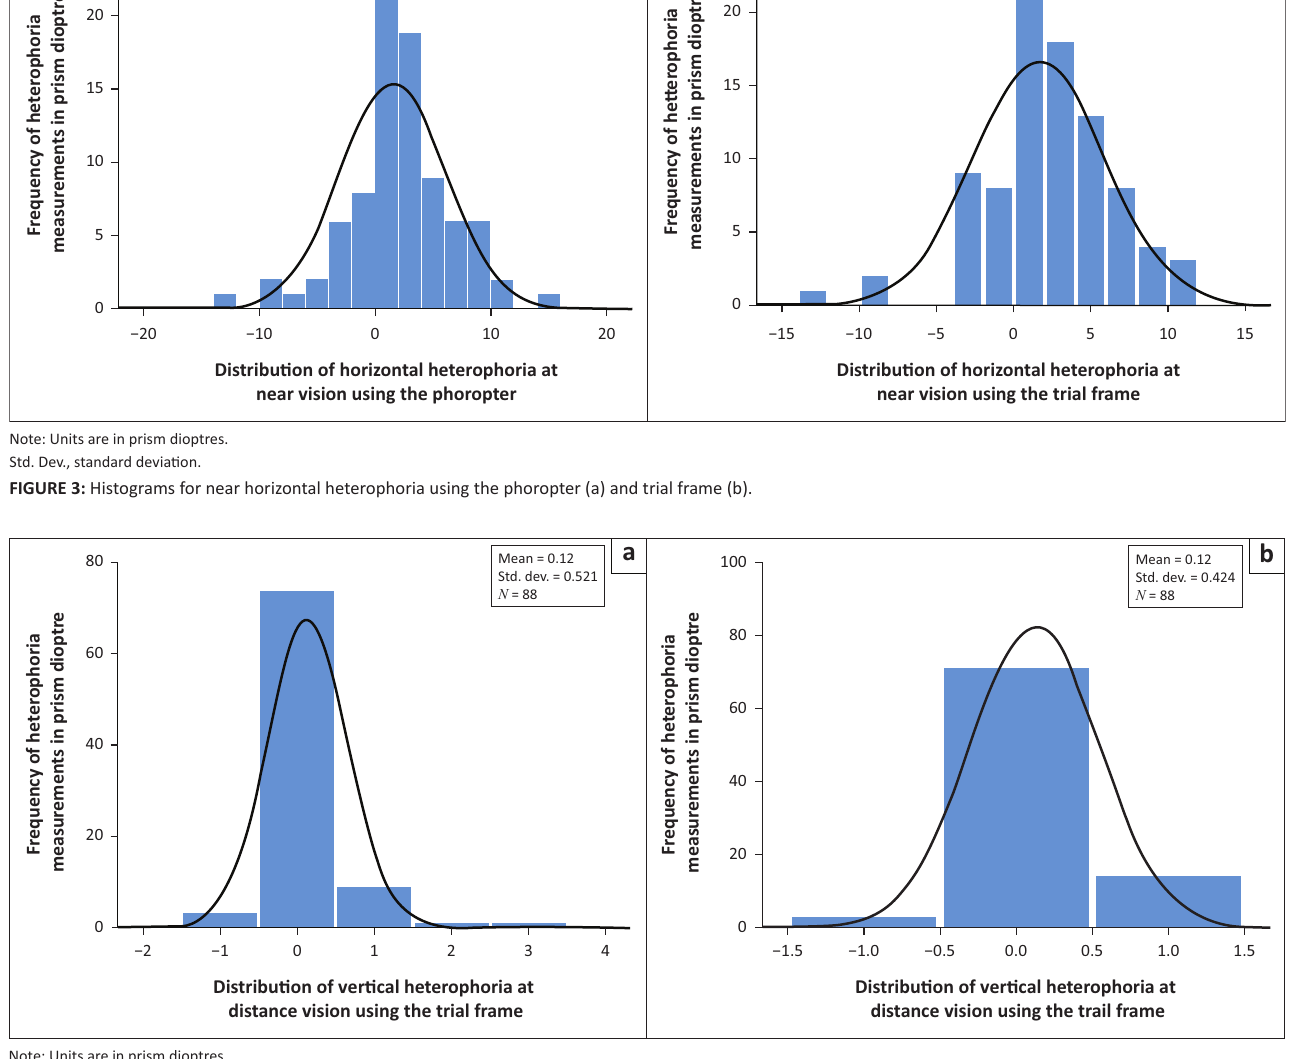
FIGURE 4: Histograms for distance vertical heterophoria using the phoropter (a) and trial frame (b). are indicated in Bland-Altman plots (Figures 7–10). The plots are based on the means of the two distance or near heterophoria measurements against their mean differences. The mean differences are represented by the red solid horizontal lines, whilst the 95 % LoA are represented by the bold upper and lower lines. The upper and the lower LoA are equal to the mean difference ( bias ) ± 1.96 × s.d. Confidence intervals (CI) (5 % ) for the LoA are represented by the dotted lines.